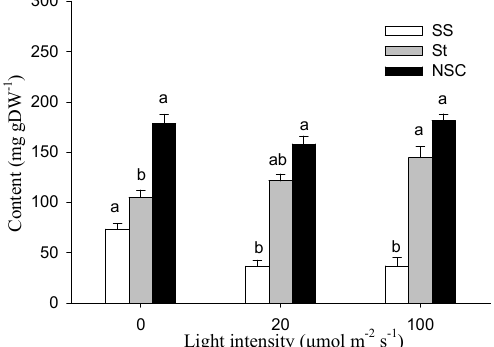
Figure 4. Effects of stem photosynthesis on soluble sugar (SS), starch (St), and NSC (SS + St) content of bud-free stem in cutting seedlings. Data were mean ± SE with n = 3. The different lowercase letters in the same index indicate a significant ( p < 0.05) difference between light treatments.